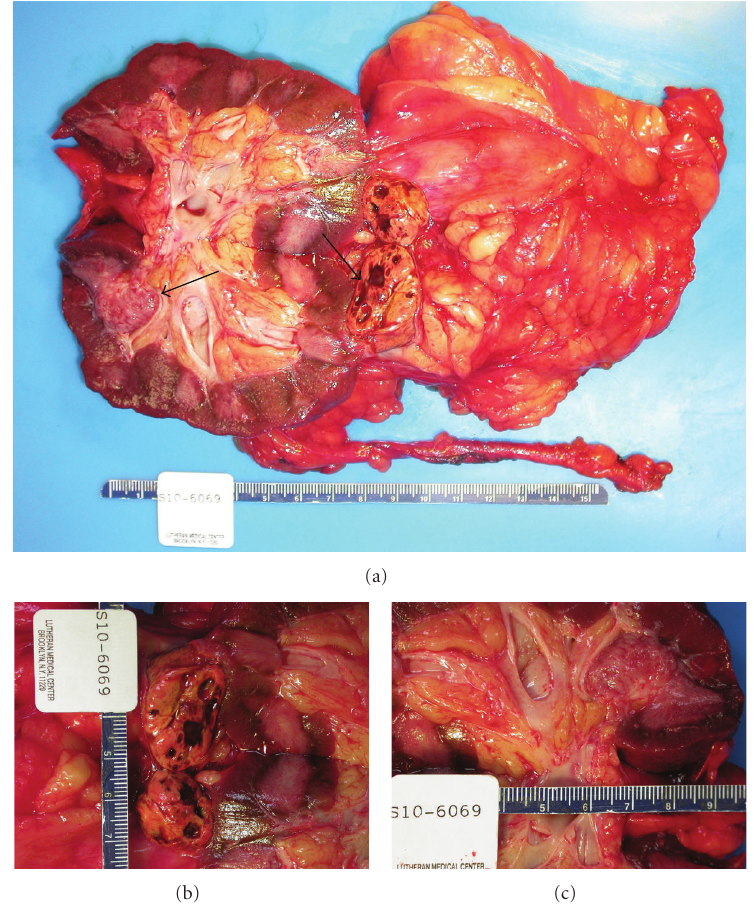
Figure 1: Right kidney nephrectomy specimen (a). A thin arrow denotes the renal cell carcinoma (b); thick arrow designates the separate synchronous low-grade papillary urothelial carcinoma (c).